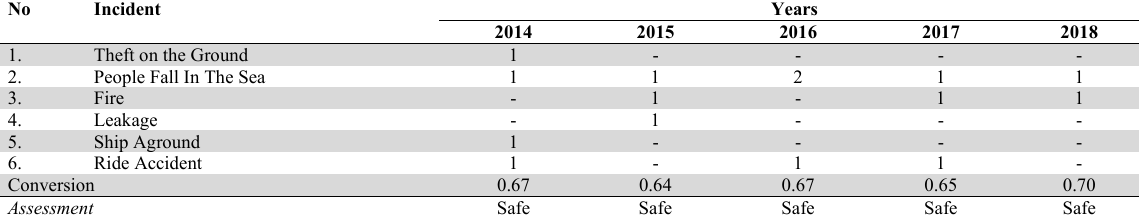
Naval Base Port Security